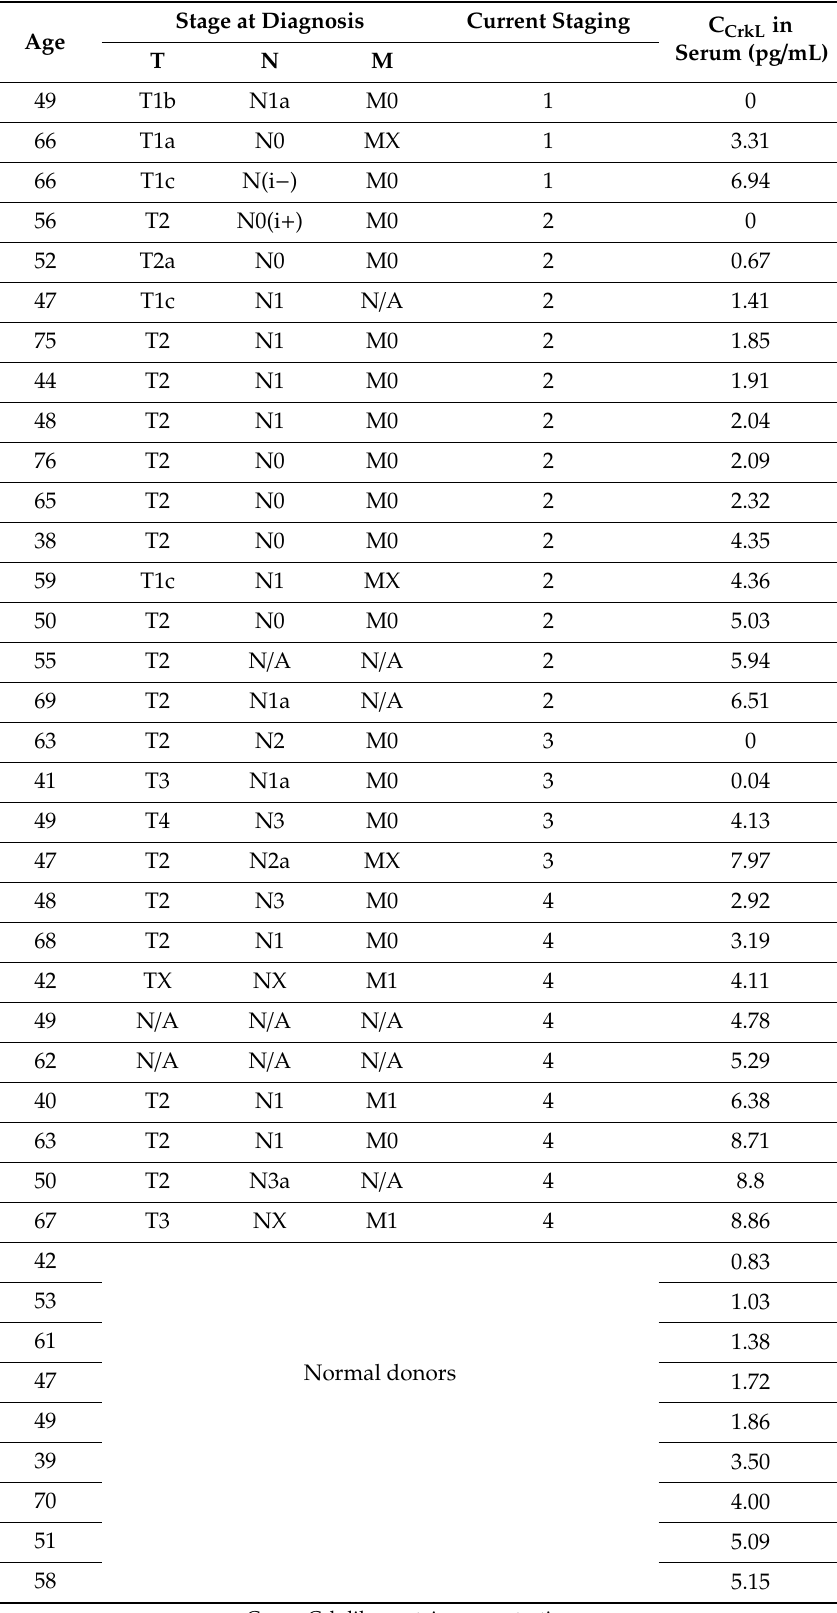
Table 2. Relationship between soluble CrkL fraction in sera from breast cancer patients and pathological